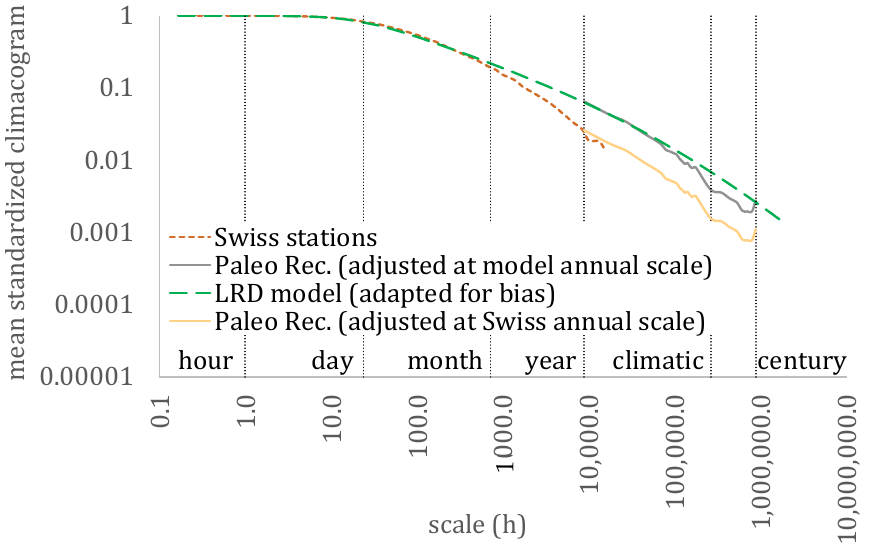
Figure 5. The mean standardized climacogram for the analysis by Dimitriadis et al. [6] (daily and hourly resolution), for the Swiss dataset (10 min resolution) and for the paleoclimatic reconstructions (annual resolution).